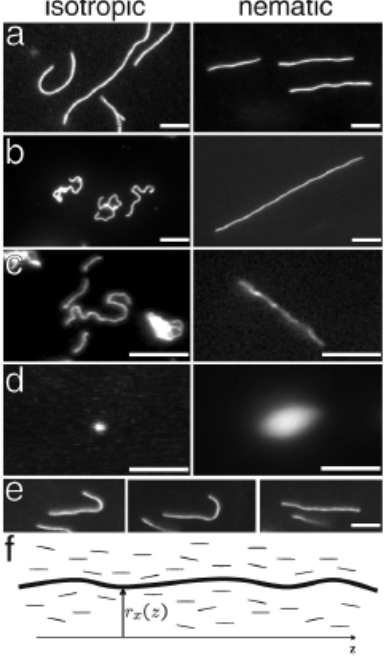
Figure 6. Images of fluorescently labeled biopolymers in the isotropic (left panels) and nematic (right panels) phases of the fd virus. ( a )–( d ) are, respectively, the images of actin, worm- like micelles, neurofilaments, and DNA. The polymers in an isotropic solution are confined by a thin chamber thus making the samples quasi two dimensional; ( e ) A sequence of images illustrating an actin filament escaping from a hairpin defect. The scale bar is 5 µm; ( f ) A schematic of a biopolymer in the background nematic field; the conformation of the ( z ) , r ( z ) , z } . The nematic director points along polymer is parametrized by R ( z ) = { r x y the z axis. Image and caption taken from [41], Copyright 2004 by The American Physical Society, with